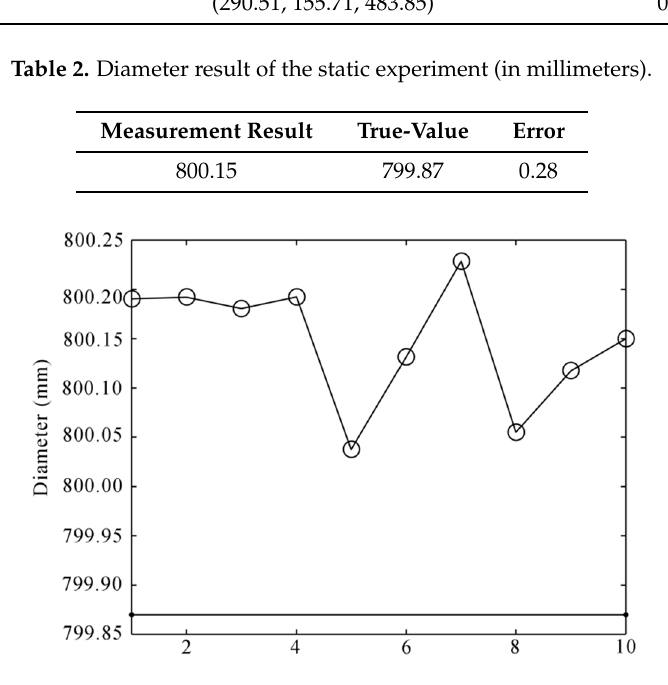
Figure 20. The diameter results of ten static measurements.